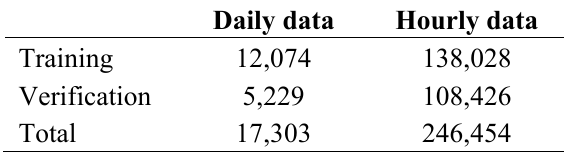
Table 2. Number of data used for training and